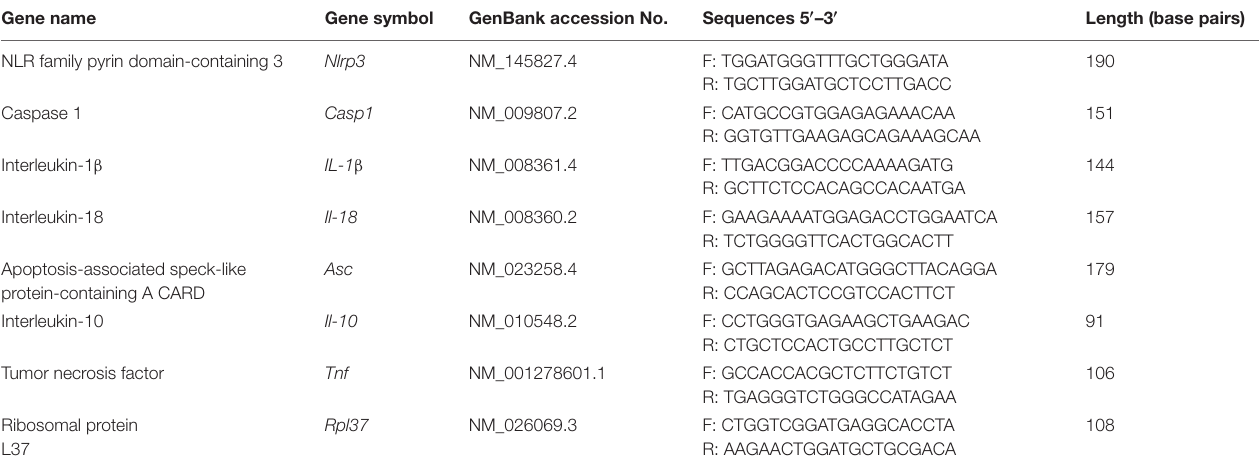
TABLE 2 | Specific primers used for quantitative real-time